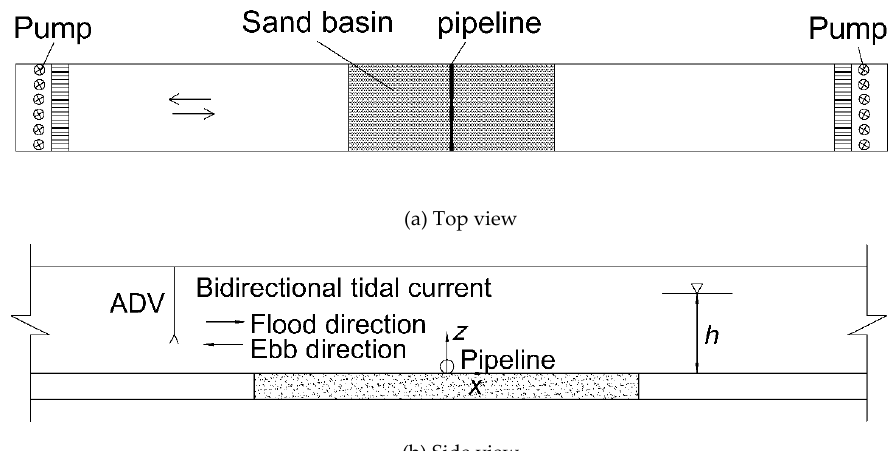
Figure 3. Experiment setup: ( a ) top and ( b ) side view. Experimental runs were carried out under bidirectional tidal current and unidirec- tional current conditions, respectively. Considering the characteristics of the stronger flow in Hangzhou Bay, the live-bed unidirectional current conditions ( u > u c ) were studied in the experiment. Details of the experimental flow conditions are listed in Table 1. Accord- ing to Froude’s law, the length scale between the model experiment and prototype was 1:20, and the time scale between the laboratory experiment and the prototype was 1:4.47. Therefore, the period of tidal current in the laboratory experiments was 2.68 h, corre- sponding to the period of 12 h in the prototype. The tidal current in the experiment was simplified as a regular sinusoid tide: 𝑢 (cid:3047) = 𝑢 (cid:2923)(cid:2911)(cid:2934) sin(cid:4666)2𝜋𝑡/𝑇(cid:4667)